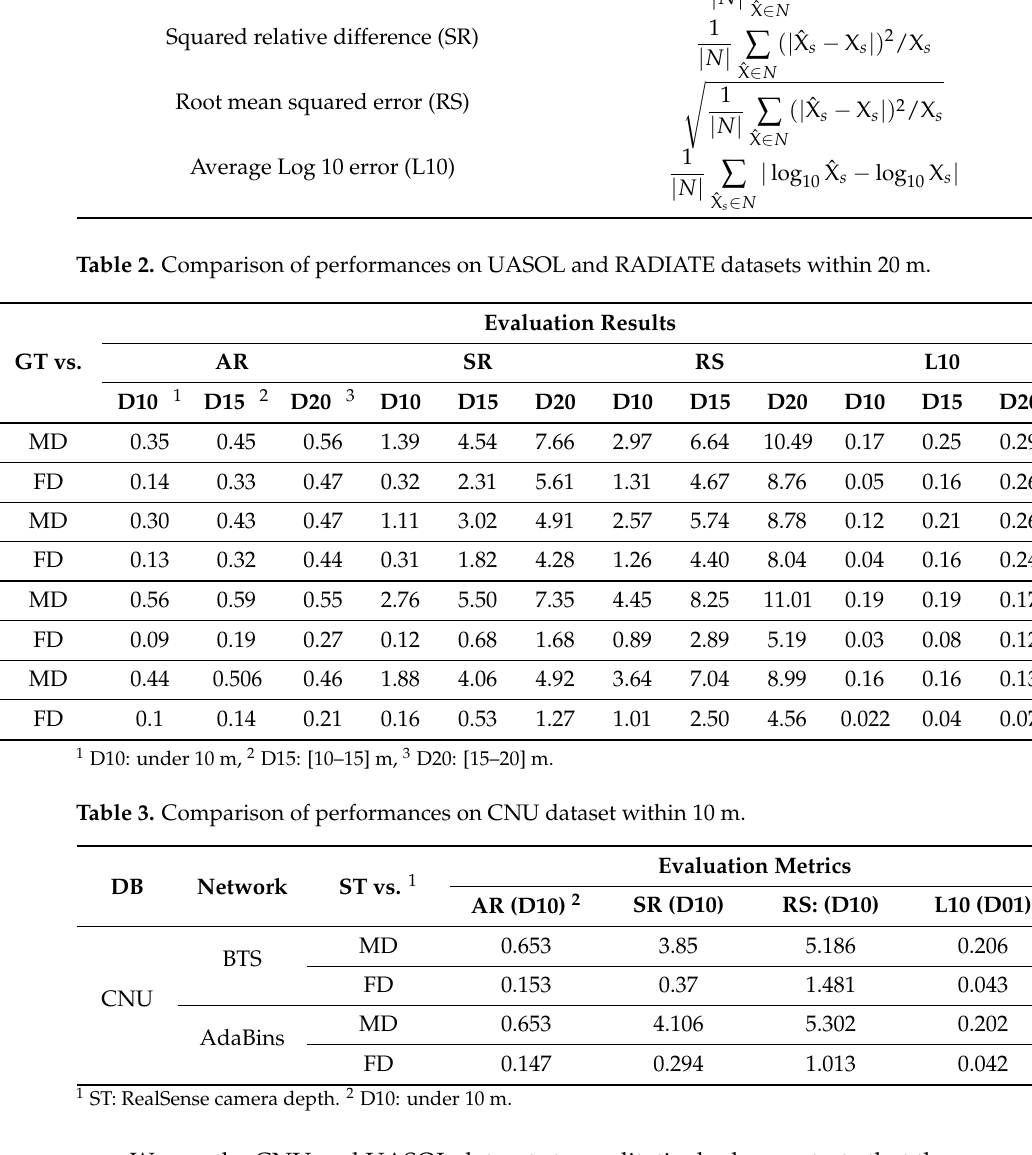
Table 1. Evaluation metrics.